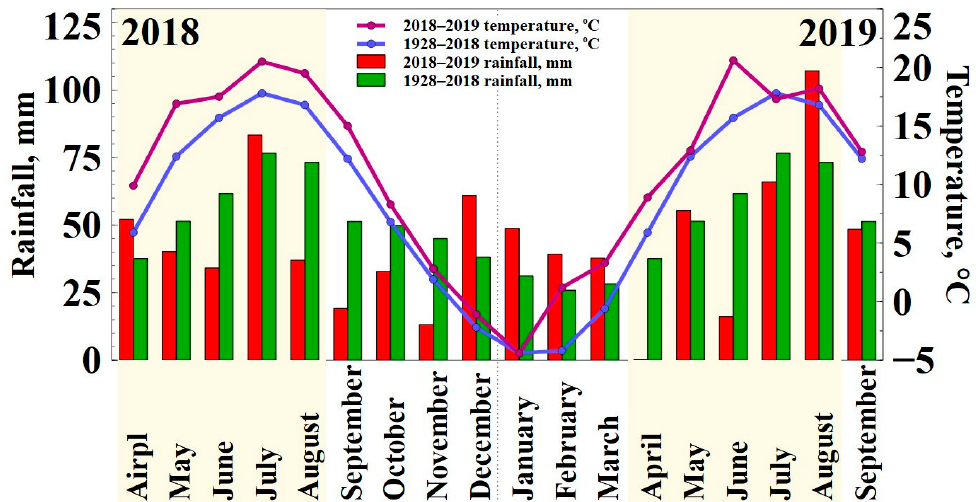
Figure 1. Rainfall sum (mm) and the average temperature (°C) for the testing period of 2018–2019, as well as the long-term average (1928–2018). The shaded area represents the time when the spring wheat (2018) and spring triticale (2019) were grown.